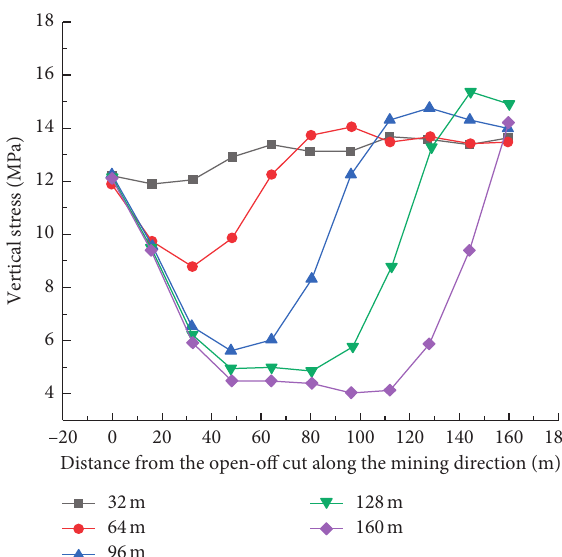
Figure 11: Vertical stress curve for the No.2-1 coal seam in the mining of the rock-coal composite protective layer.